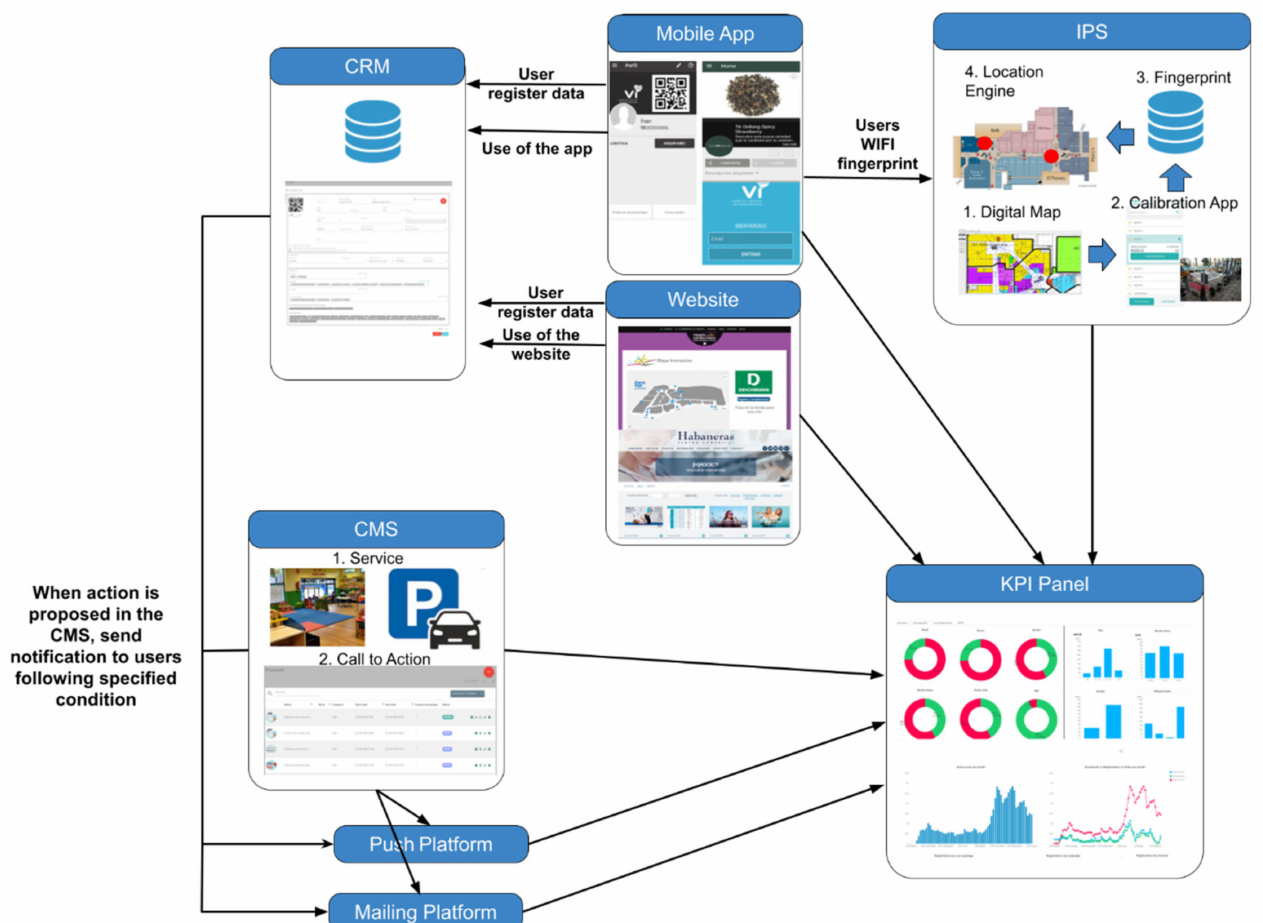
Figure 1. The complete architecture of the contextual marketing